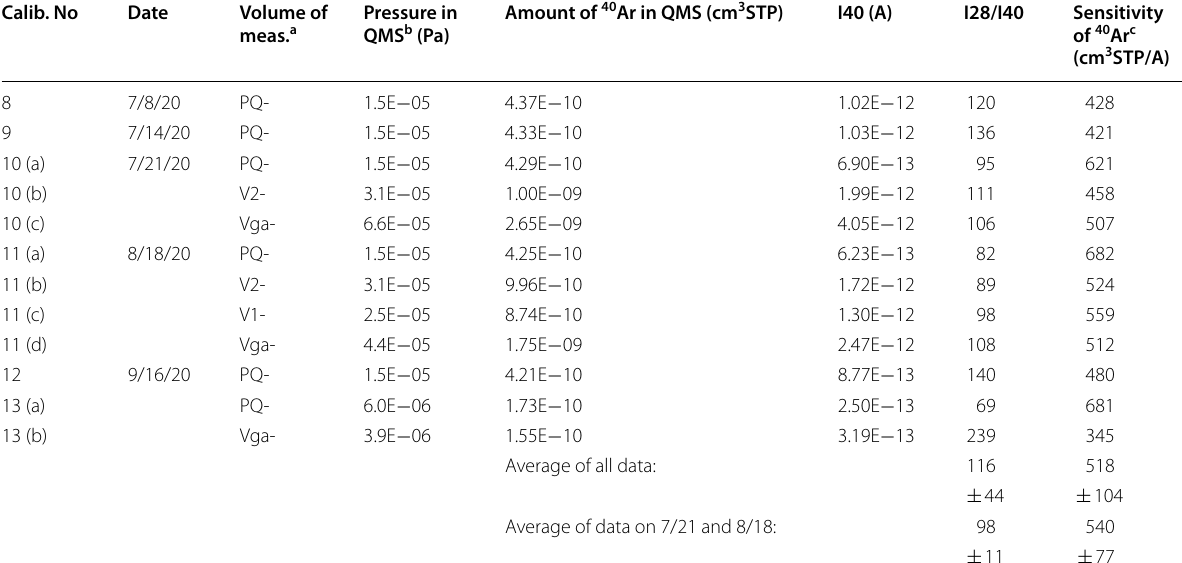
Terrestrial atmosphere was used as calibration gas. Volume fraction of 40 Ar is 0.0093 a Volumes to which calibration gases were introduced for the QMS measurements